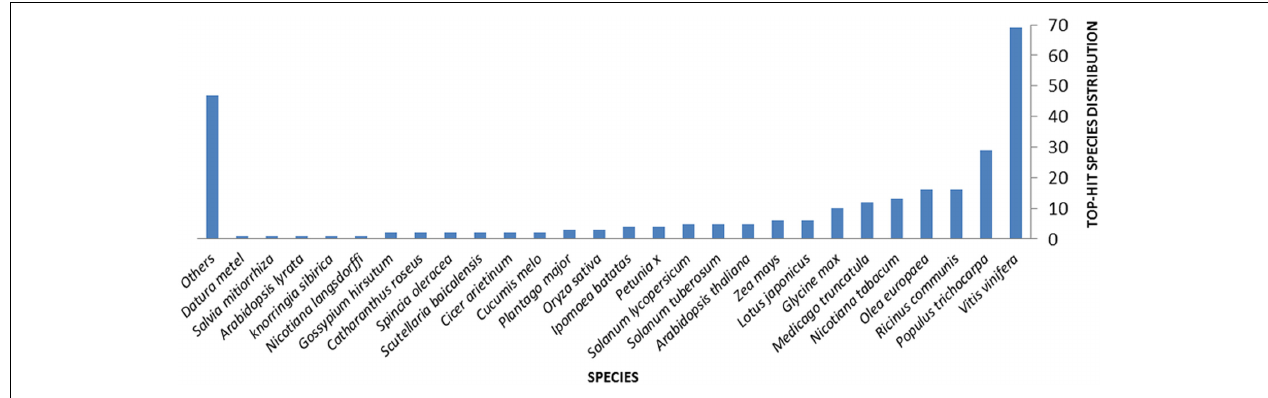
FIGURE 1 | Distribution of hits of the complete assembly obtained against sequences available in Uniprot for different plant species.